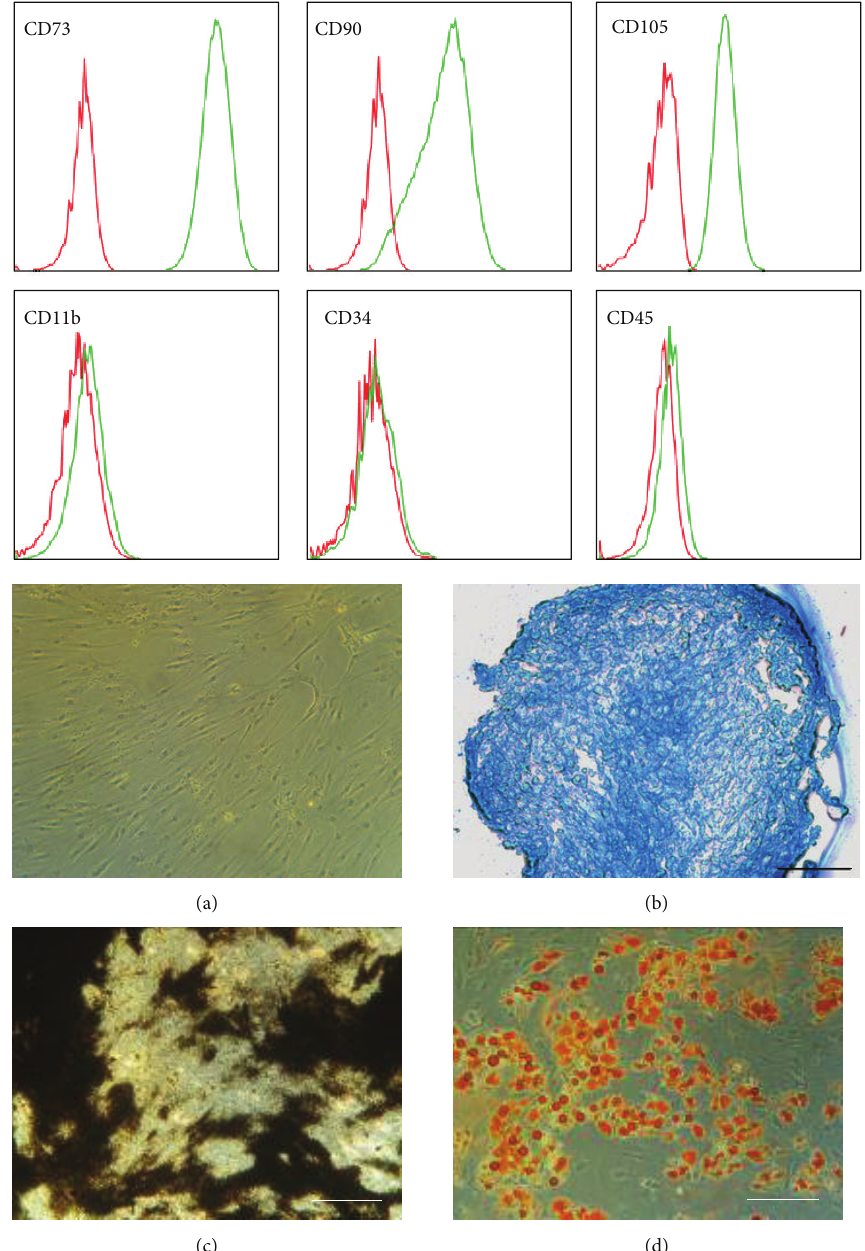
Figure 2: Human mesenchymal stromal cells from bone marrow (bmMSCs) are defined by their expression of CD73, CD90, and CD105, by lack of expression of a series of other cell surface markers such as CD11b, CD34, and CD45, and by a fibroblastoid appearance (a) and trilineage differentiation to generate chondrocytes (b), osteoblasts (c), or adipocytes (d) (for further details see